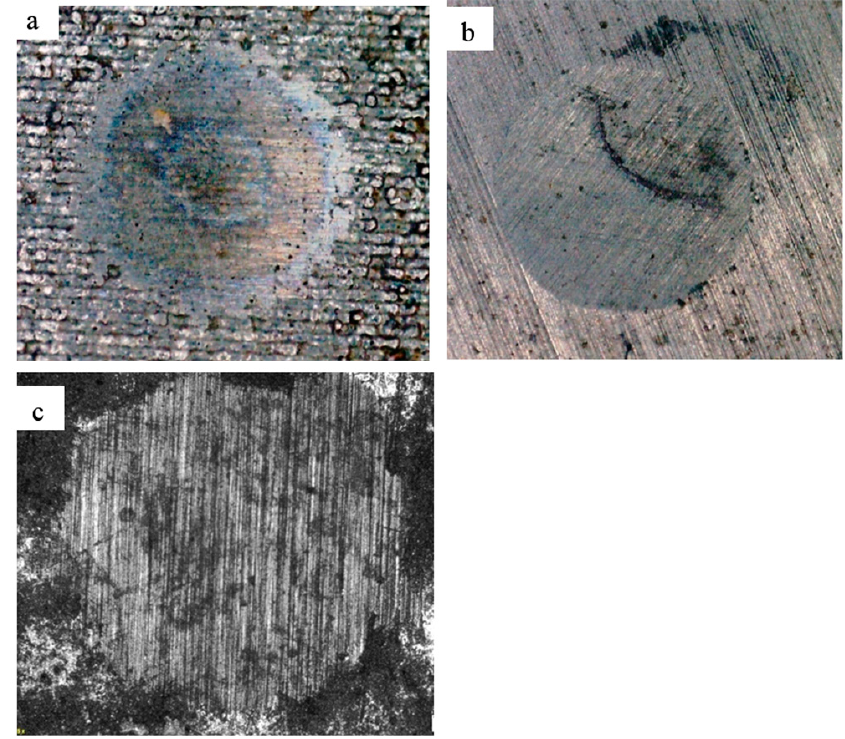
Figure 15. The observed wear scars on the surface of the tested samples: ( a ) 94 wt% WC and 6 wt% Co, ( b ) BK6, ( c ) BK20.